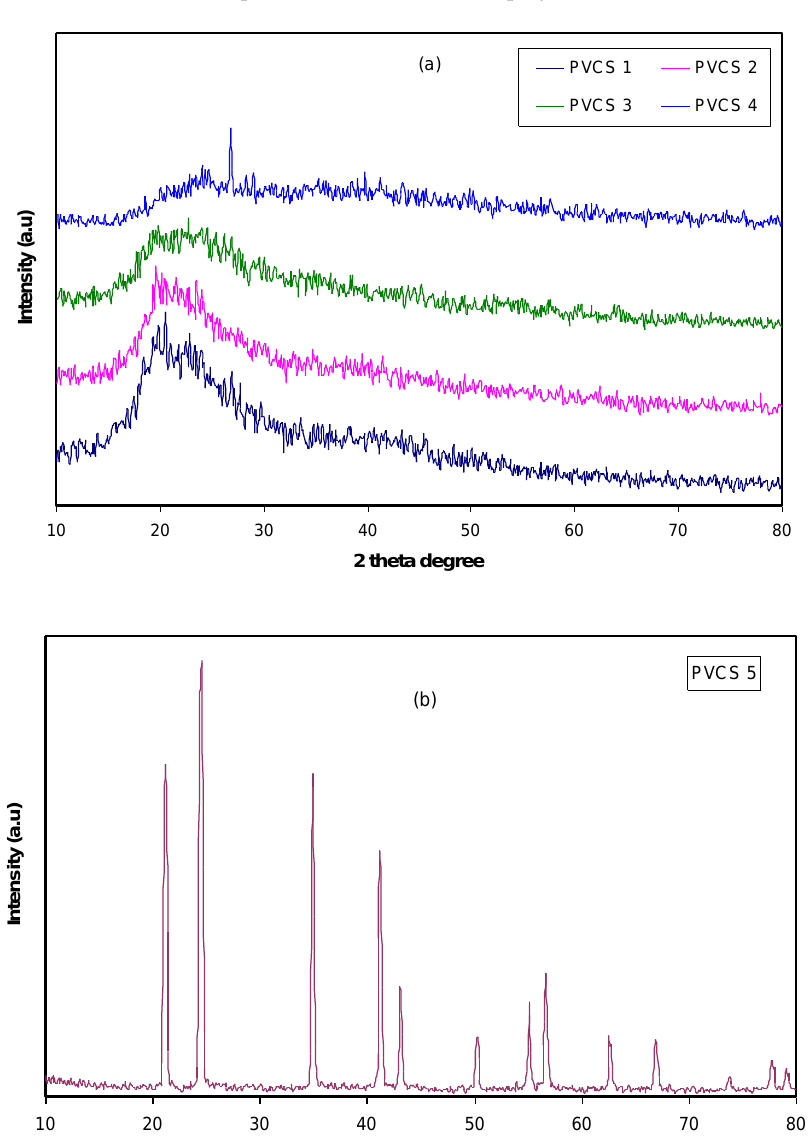
Figure 3. XRD pattern for PVA:CS [50:50] polymer blend electrolytes ( a ) from 10 to 40 wt.% of NH 4 I and ( b ) for 50 wt.% of NH 4 I.